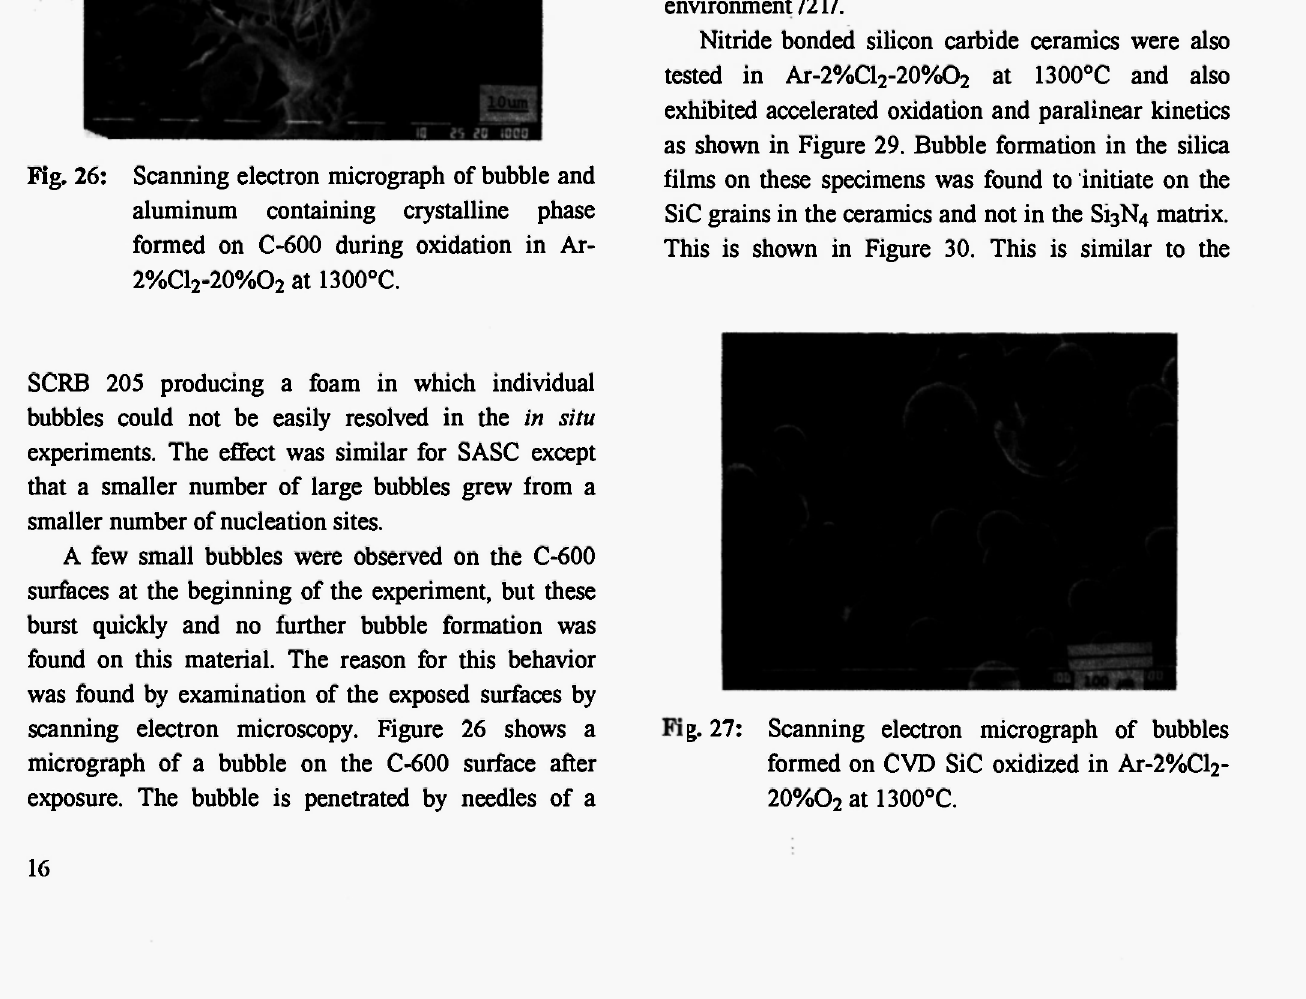
Fig. 26: Scanning electron micrograph of bubble and aluminum containing crystalline phase formed on C-600 during oxidation in Ar- 2%C1 -20%0 at 1300°C. 2 2